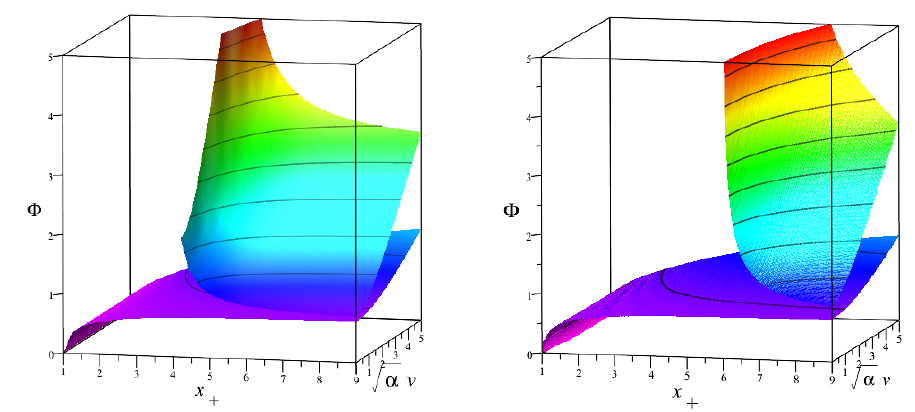
(cid:0) (cid:1) @ (cid:22) P=@ (cid:22) v = 0 is shown. At the right hand (cid:8) ; (cid:22) T (cid:0) (cid:1) @ 2 (cid:22) P=@ (cid:22) v 2 = 0. (cid:8) ; (cid:22) T